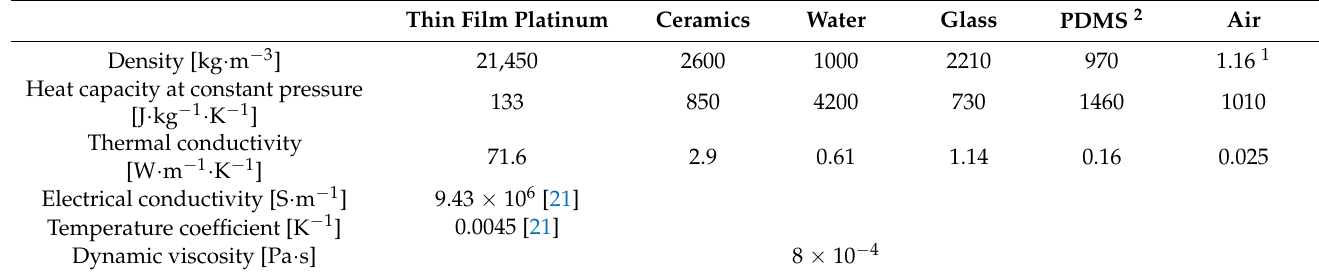
Table 1. List of material properties at T = 300 K that were required by three physical models in the Comsol simulation